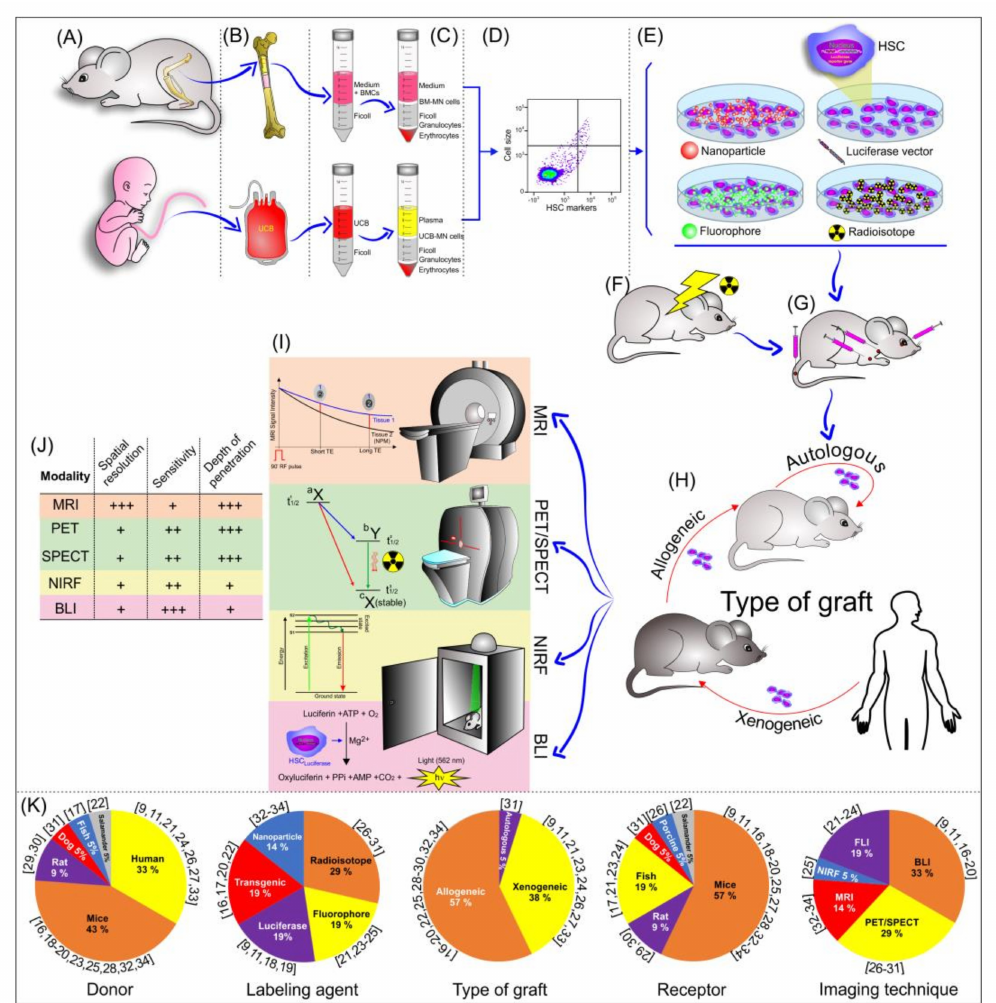
Figure 2. Schematic illustration of the bone marrow transplantation process, from the isolation of HSCs to their implantation, and tracking evaluation by noninvasive imaging techniques. ( A ) Main cell donors; ( B , C ) main cell sources for HSC extraction; ( D ) HSC characterization after isolation; ( E ) contrast agent used in the HSC labeling; ( F ) animal pre-condition (irradiation) before HSC transplantation; ( G ) cell route used in the transplantation; ( H ) type of graft; ( I ) noninvasive imaging technique used in HSC tracking; ( J ) imaging modality features; and ( K ) the graphic of the percentual distribution of the main element analyzed in the systematic